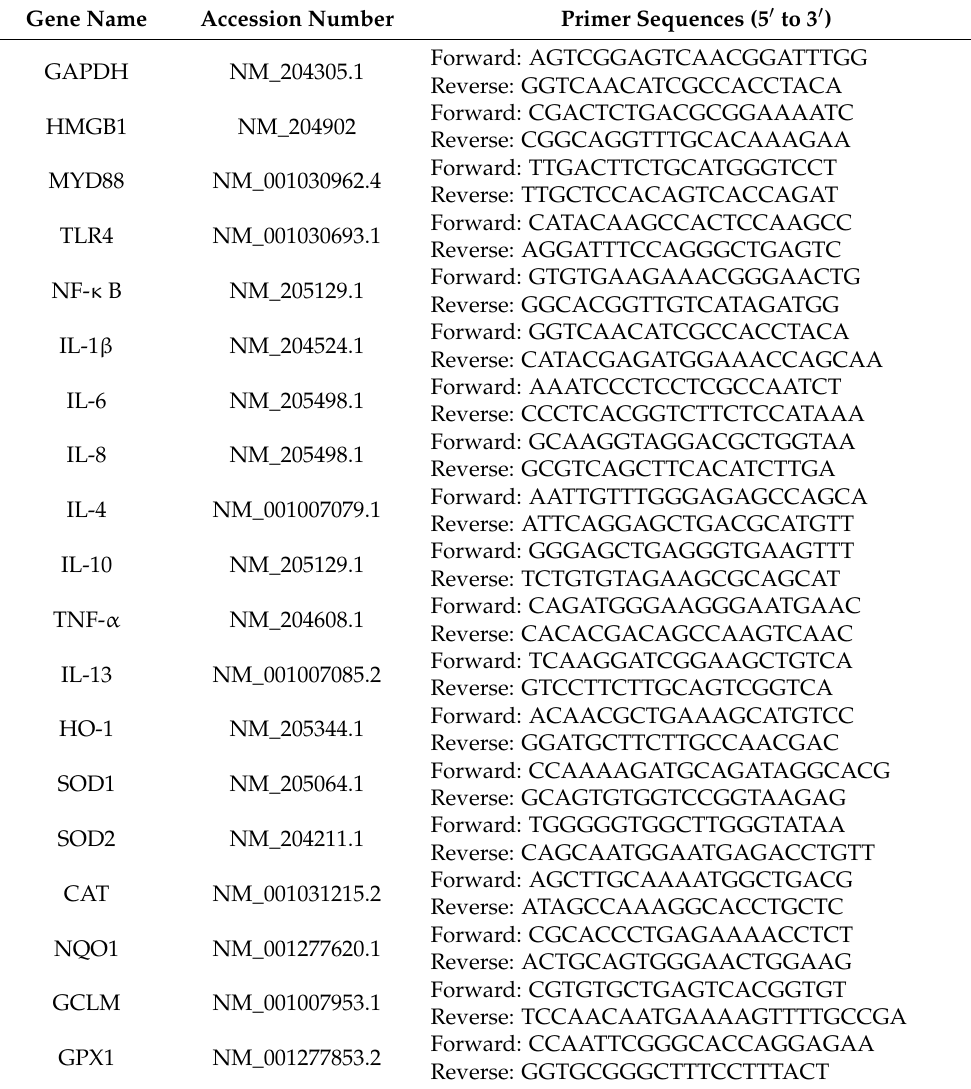
Table 2. Sequence of the gene primers and the GenBank accession